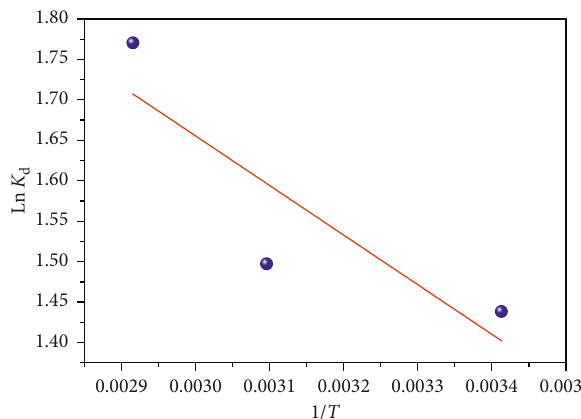
Figure 11: Enthalpy and entropy change determination of the adsorption of MB by geopolymer. Table 9: Thermodynamic parameters for the adsorption of MB onto geopolymer.